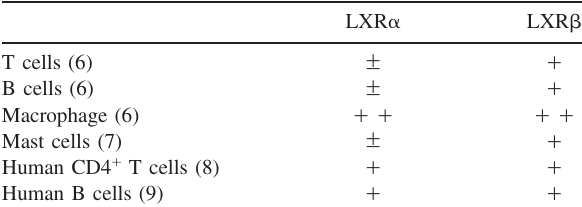
Table 1 LXR expression in immune cells.